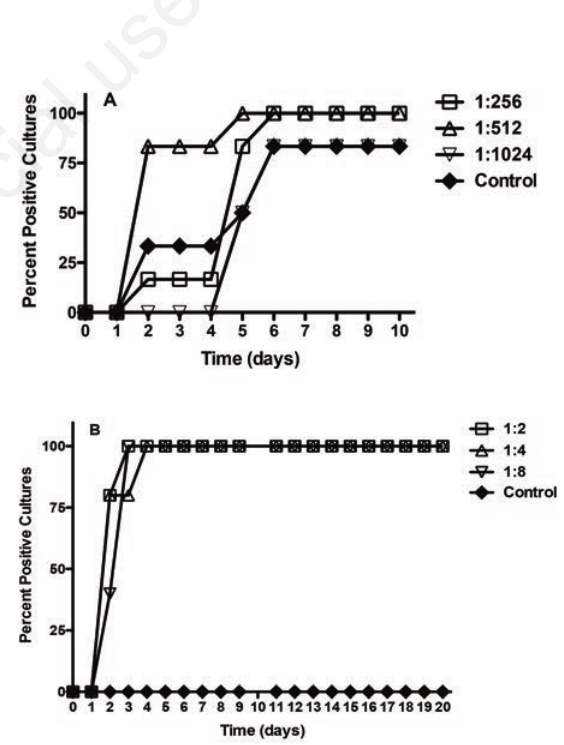
Figure 4. Oxyrase® for Broth (OB) increases the number of Mycobacterium avium subsp. paratuberculosis (MAP) cultures that recover from dormancy. The optical density (590 nm) of MAP grown in Middlebrook 7H9C containing serial dilutions of OB was measured daily until growth ceased or contamination was observed. Wells were regarded positive if the optical density was greater than 0.085 OD units greater than the plate average at 590 day 0. Only the dilutions of OB that affected MAP growth are shown. A) Experiment 1. B) Experiment